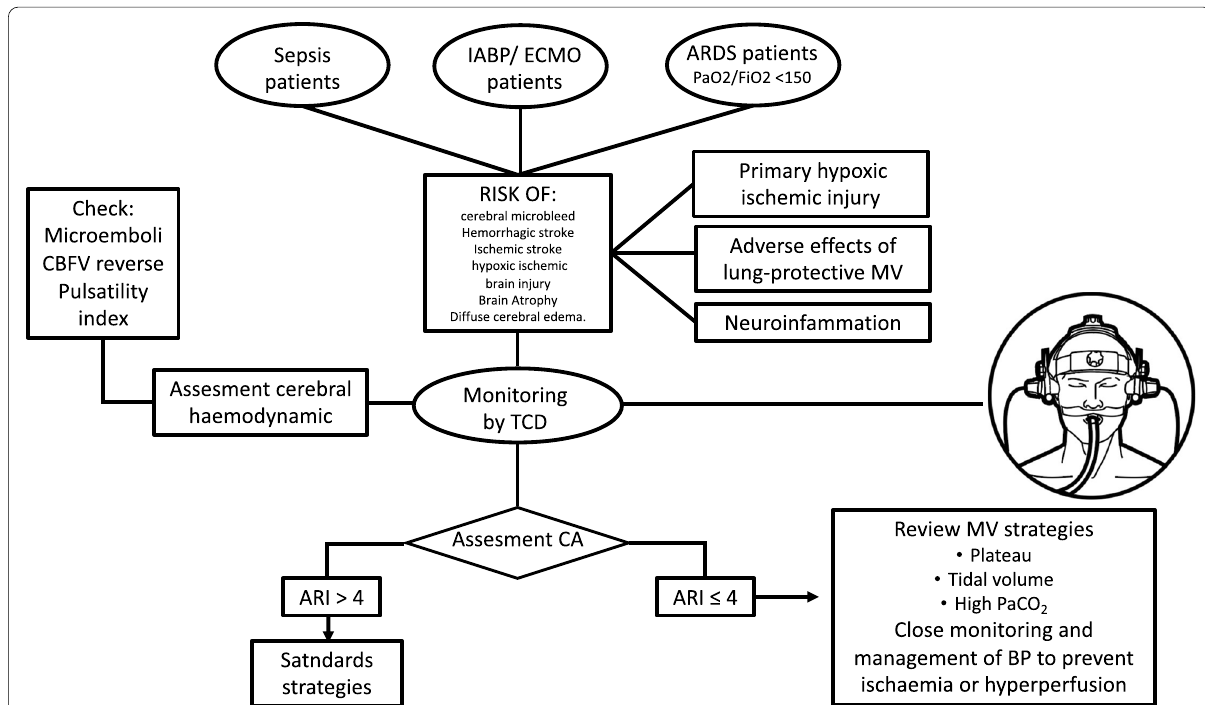
Fig. 8 Monitoring of cerebral blood flow regulation in critical care scenarios. ARDS, acute respiratory distress syndrome; IABP, intra-aortic balloon pump; ECMO, extracorporeal membrane oxygenation; TCD, transcranial Doppler; CBFV, cerebral blood flow velocity; ARI, autoregulation index; CA, cerebral autoregulation; MV, mechanical ventilator; PaCO2, partial pressure of carbon